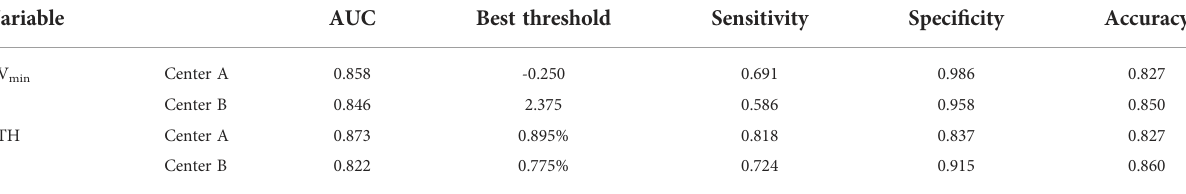
TABLE 3 Comparison of diagnostic ef fi cacy of AVmin and CTH for adenoma with AV mean >10 HU in two centers. Variable